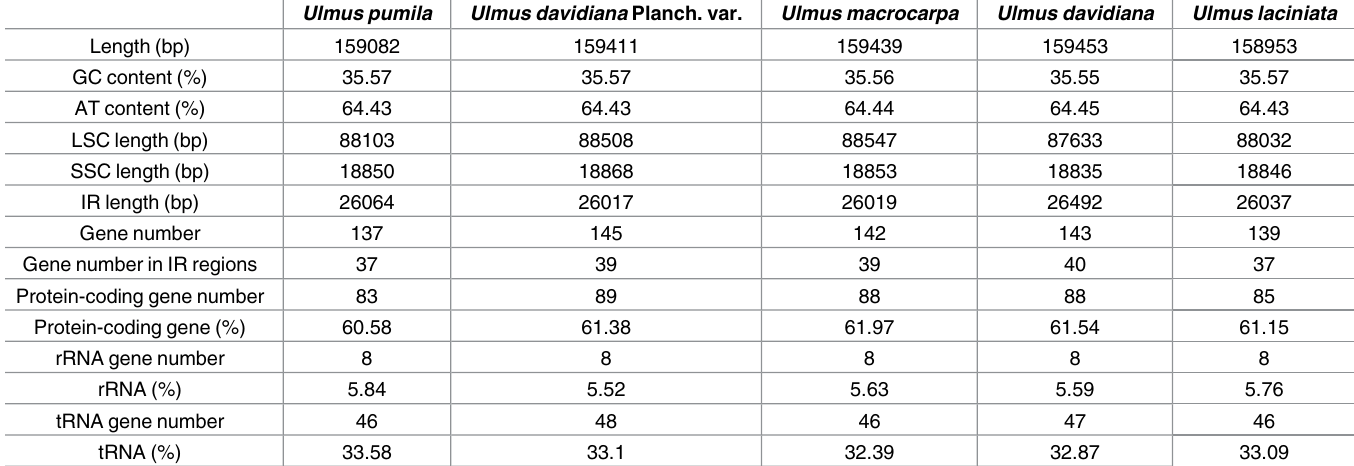
Table 1. Statistics on the basic features of the chloroplast genomes of five Ulmus